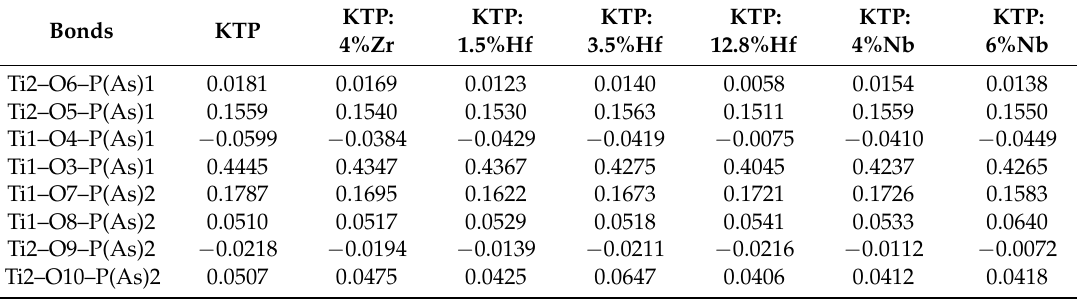
Table 5. Degree of deviation ( ∆ ) from the difference of the average Ti–O and P(As)–O interatomic distances in the structures of pure KTP [46], KTP:4%Zr [36], KTP:1.5%Hf, KTP:3.5%Hf, KTP:12.8%Hf [37], KTP:4%Nb, and KTP:6%Nb